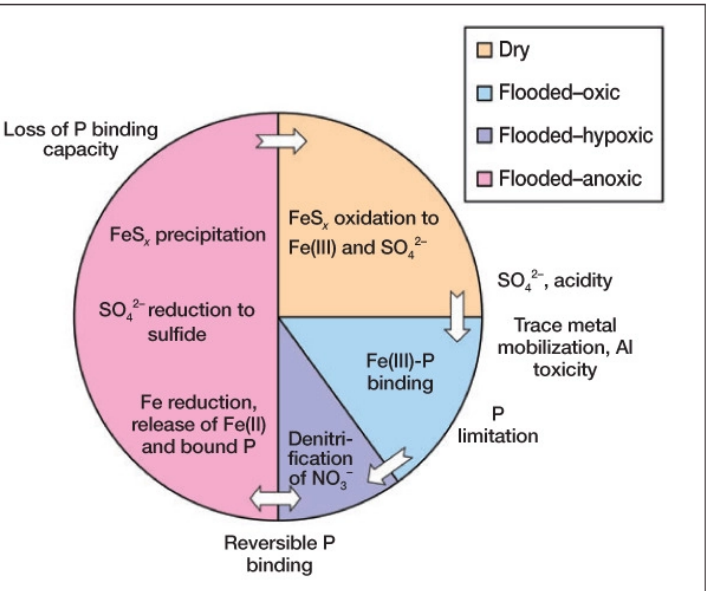
Figure 6. Model of possible changes in Fe and S cycling under dry and flooded conditions and their implications for P availability in sediments and soils. Source: [38]. Reproduced with permission from J. Wiley & Sons.